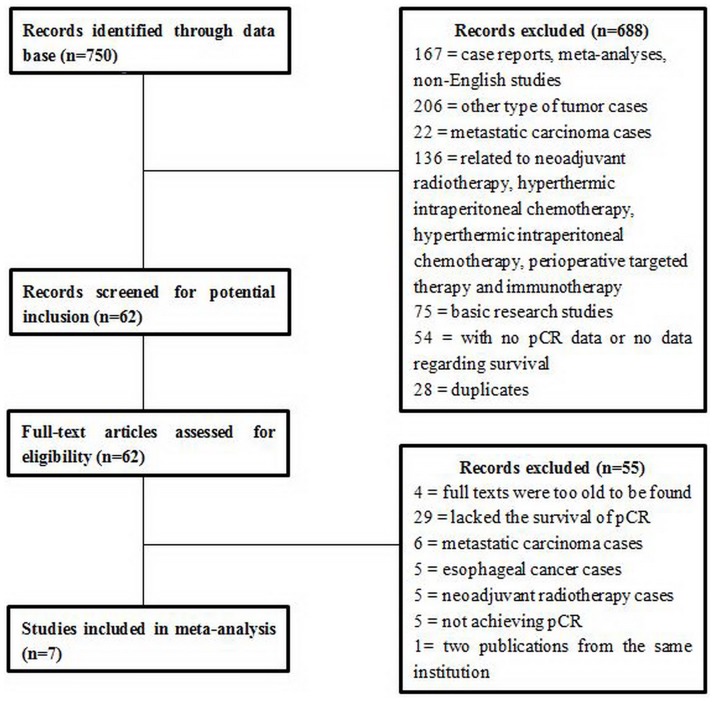
PRISMA diagram.The figure displays the information retrieval process for valuable articles and exclusion process of irrelative articles for this research.